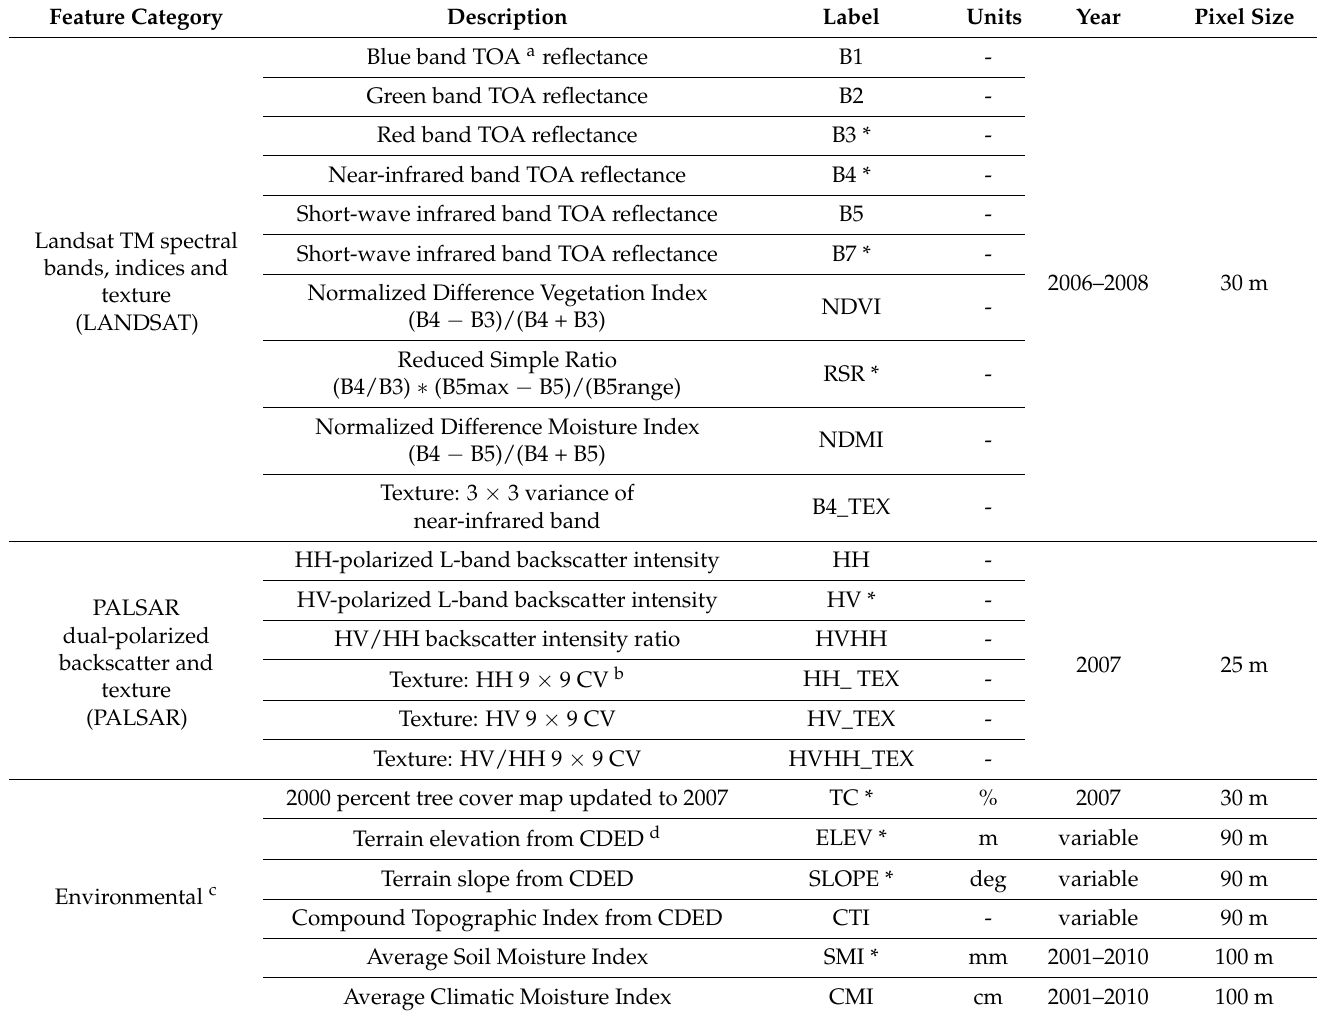
Table 1. Description of categorized candidate feature variables for k -NN prediction and mapping. Labels with an * indicate feature variables selected as input to the k -NN